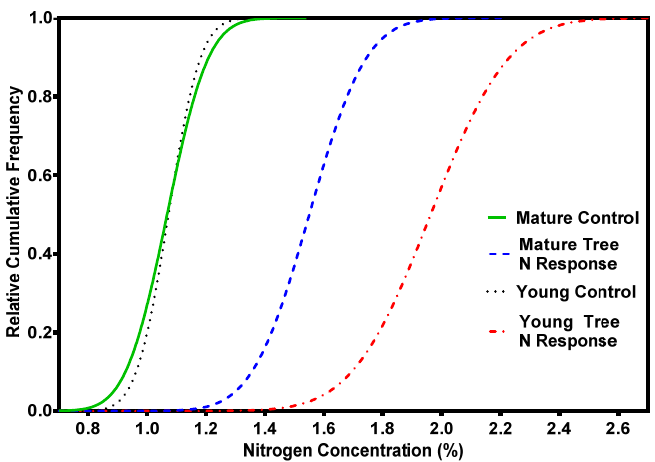
Figure 5. Grand fir foliar N response additions for young (~15 year-old) and mature (~40 year-old) stand ages [16]. (Foliage samples were collected one-year after fertilization with 224–336 kg N ha − 1 as urea).